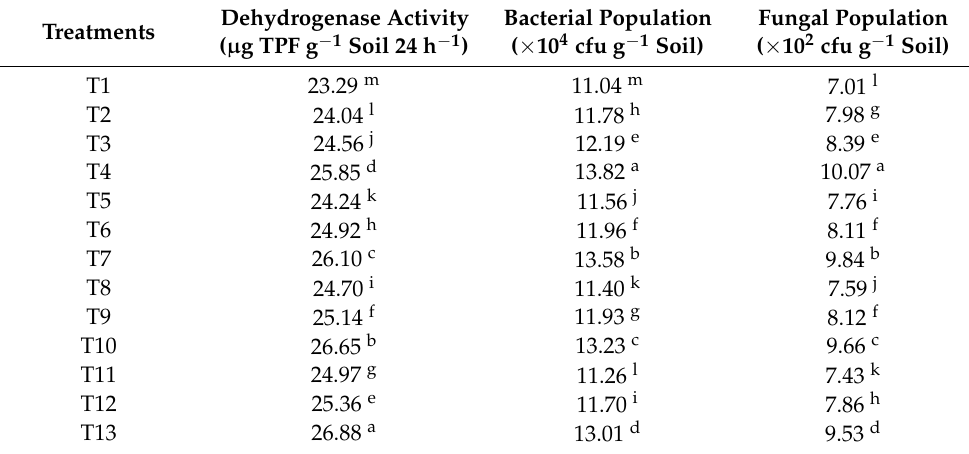
Table 2. Effect of different organic and inorganic treatments on mean value of soil biological